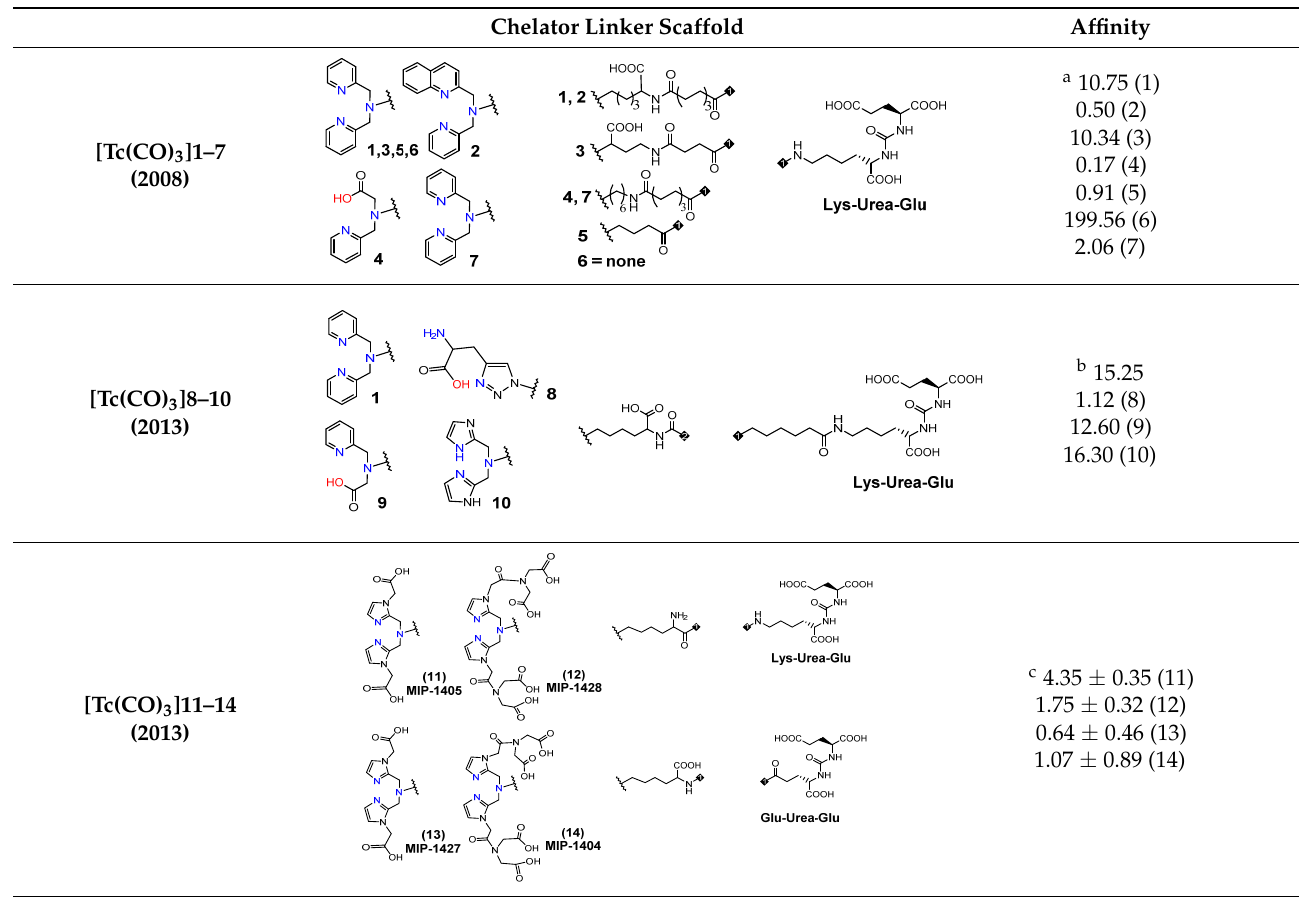
Table 3. PSMA-i labeled with [ 99m Tc][Tc(CO) 3 ] + -fragment. Chelator Linker Scaffold